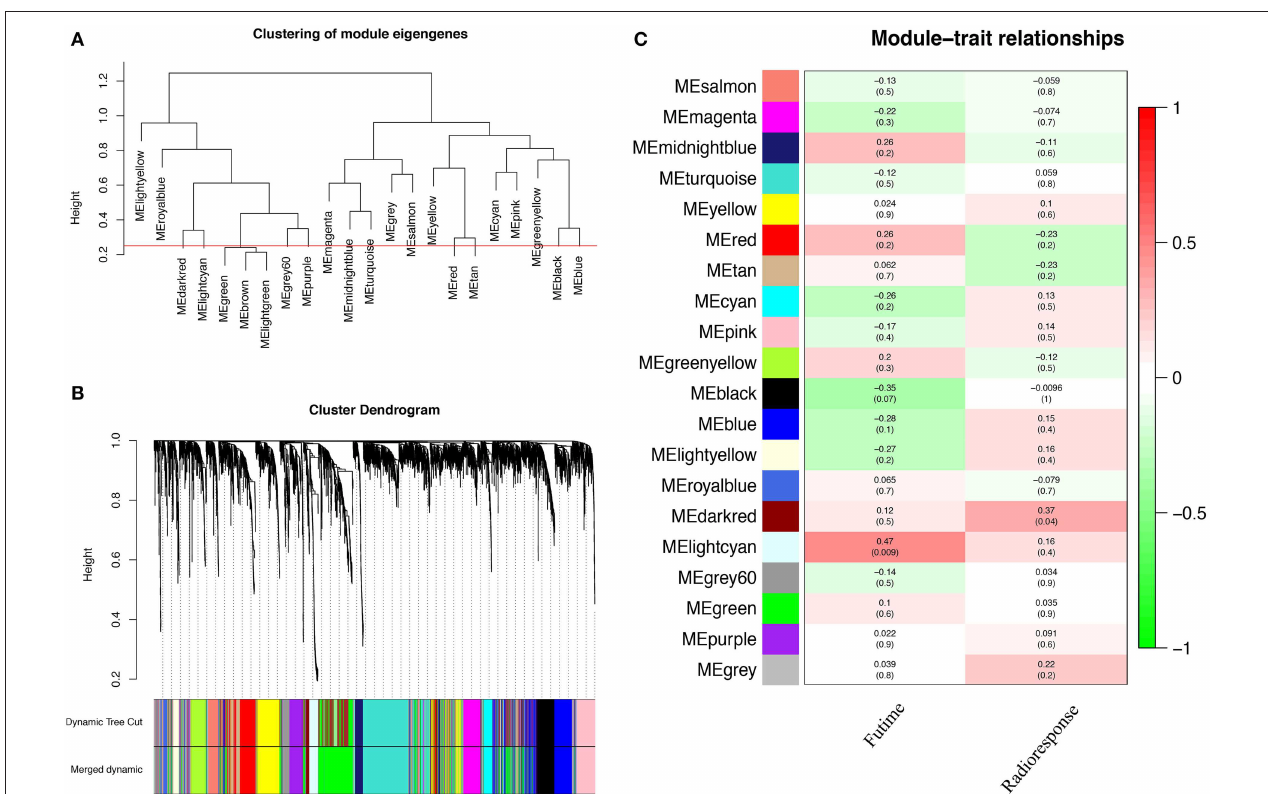
FIGURE 2 | Identification of PCG modules associated with the radioresponse of PCa. (A) The horizontal line defines the threshold, so 20 distinct PCG modules are identified. (B) The dendrogram of all genes is clustered based on a dissimilarity measure (1-TOM). (C) The heatmap shows the correlation between MEs and the radioresponse of PCa. Red represents a positive correlation between PCG modules and clinical characteristics, and green represents a negative correlation between PCG modules and clinical characteristics.